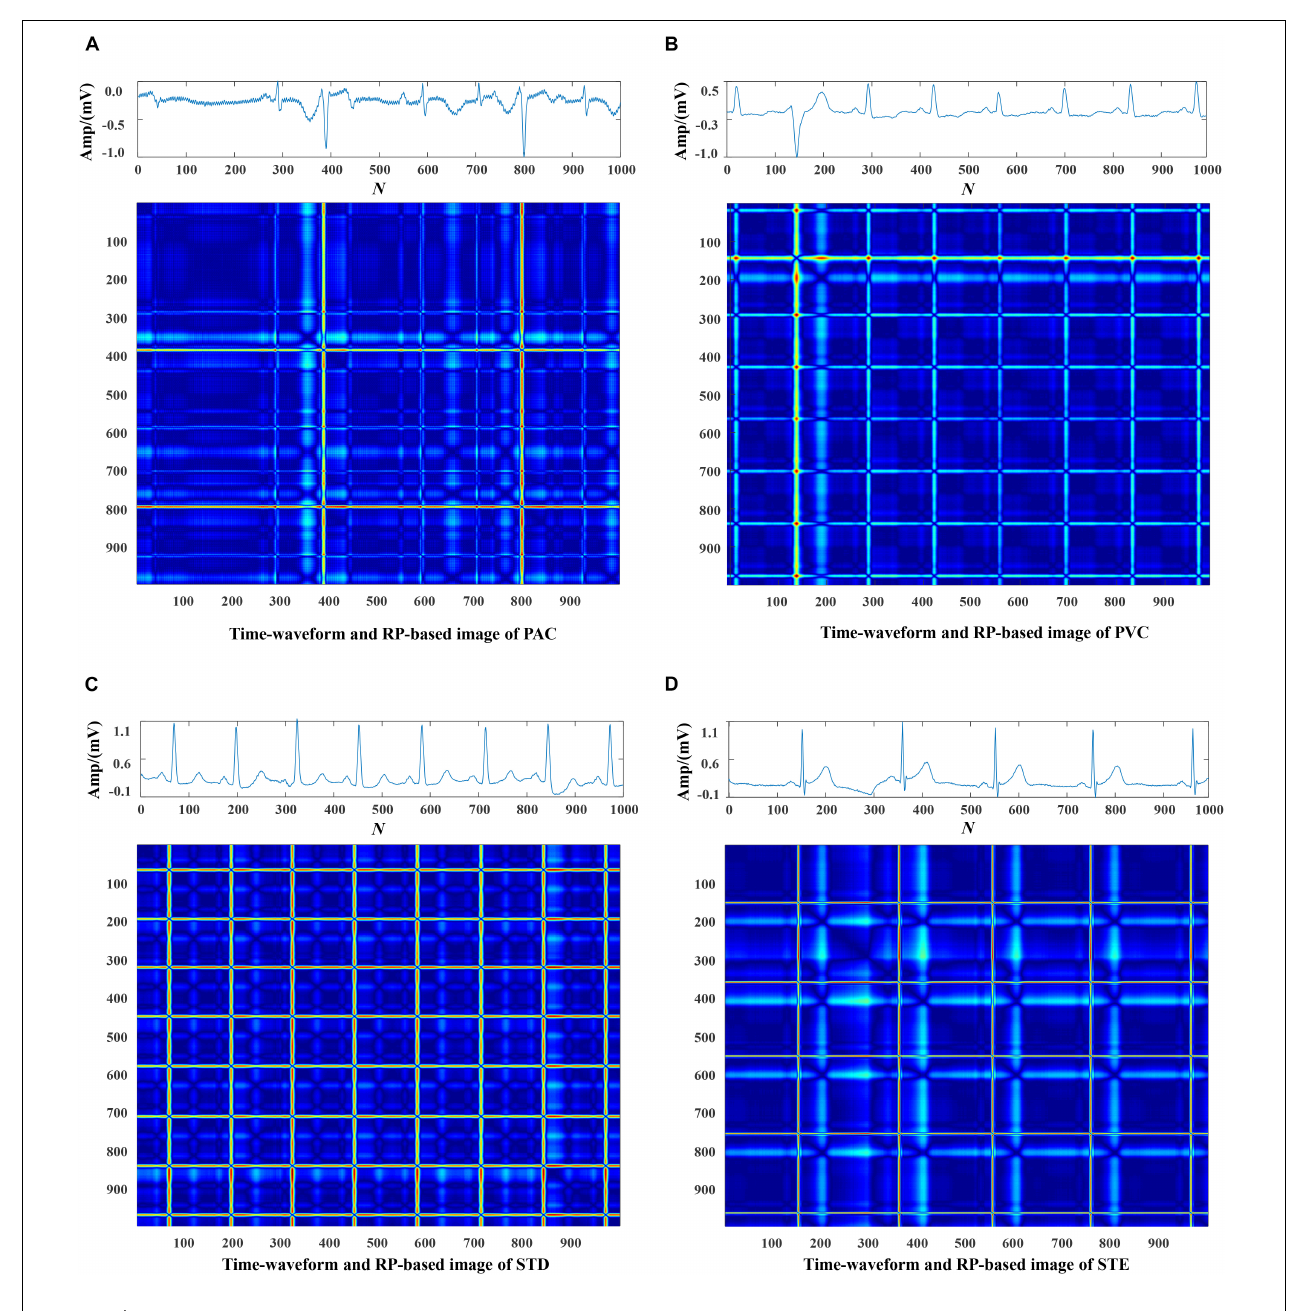
FIGURE 5 | The ECG time waveforms and their corresponding RP-based images of PAC, PVC, STD and STE.